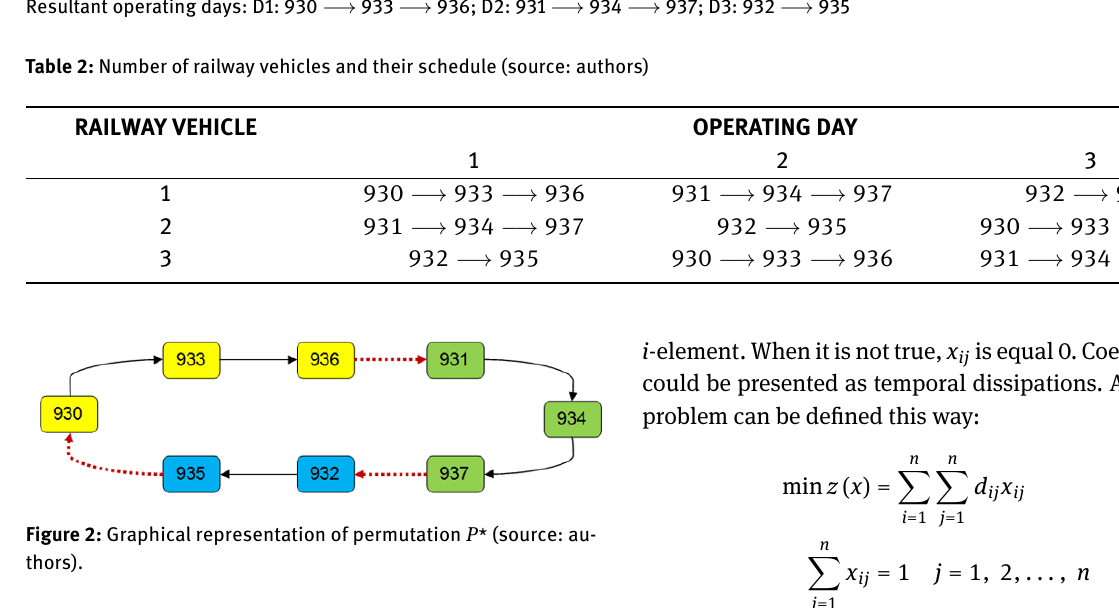
Figure 1: a) digraph for the route b) graph G with maximum flow. All edges in G have got capacity = 1